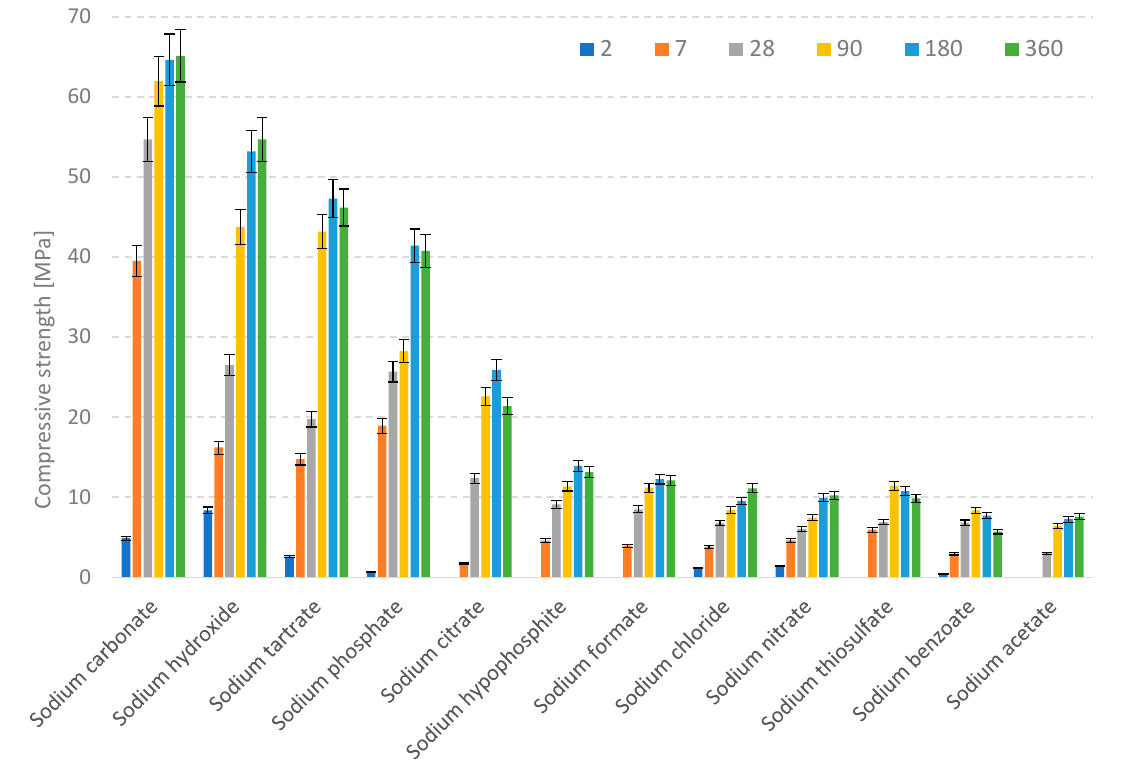
Figure 2. Changes in the compressive strength of pastes over one year of hydration. The highest compressive strength values were obtained for the samples activated with sodium carbonate. After one year of curing, a shrinkage-related decrease in strength was observed for the slag pastes activated with sodium phosphate, sodium benzoate, sodium tartrate, sodium citrate, sodium thiosulfate and sodium hydroxide. The strength development of samples containing Na 2 CO 3 was superior, compared to other series; however, the effect is most likely related to carbonate formation, as was described in the third model proposed by Shi [37]. An important factor that might have affected the compressive strength of the pastes is the varying mass of the activators used, as in the case of some of the salts, maintaining the 5 wt% Na 2 O equivalent required the introduction of large amounts of compounds. The relative amount of activators, calculated with respect to the mass of sodium hydroxide, is presented in Figure 3.